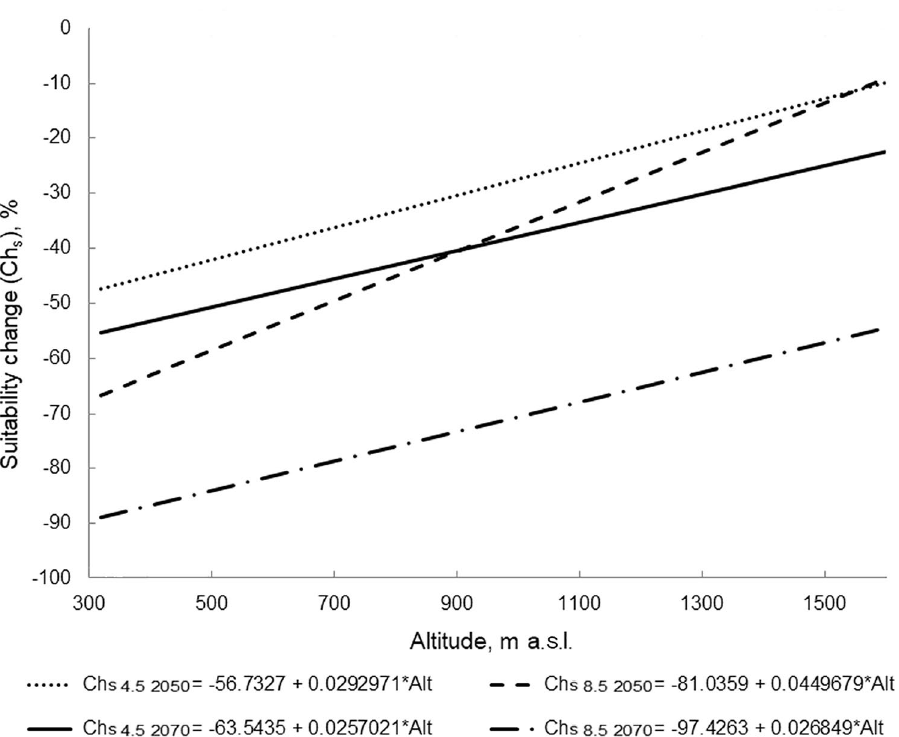
Figure 4. Results of linear regression analysis of the dependence of changes in habitat suitability (Ch s ) in the Southern Urals locations of Patrinia sibirica on their altitude (Alt) under different climate change scenarios. Ch s 4.5 and Ch s 8.5 – habitat suitability changes under the RCP4.5 and RCP8.5 climate change scenarios.